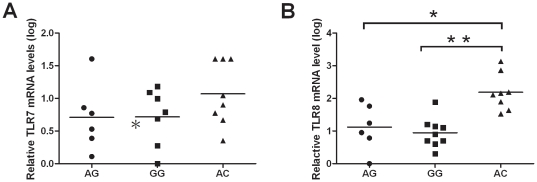
Quantitative TLR7 and TLR8 mRNA expression of individuals with different genotype by RT-PCR.The total RNA was extracted from buffy coat of male volunteers. The relative expression of TLR7 (A) and TLR8 (B) mRNA was reverse transcribed and obtained by using the 2(−ΔΔCT) method which was normalized with an endogenous control, glyceraldehydes-3 phosphate dehydrogenase (GAPDH). Each dot represents an individual, (•) represent individuals with TLR7 IVS2-151A/TLR8 -129G genotype, (▪) represent individuals with TLR7 IVS2-151G/TLR8 -129G genotype and (▴) represent those with TLR7 IVS2-151A/TLR8 -129C genotype. The horizontal bars represent mean value. *: p-value<0.05. **: p-value<0.001.